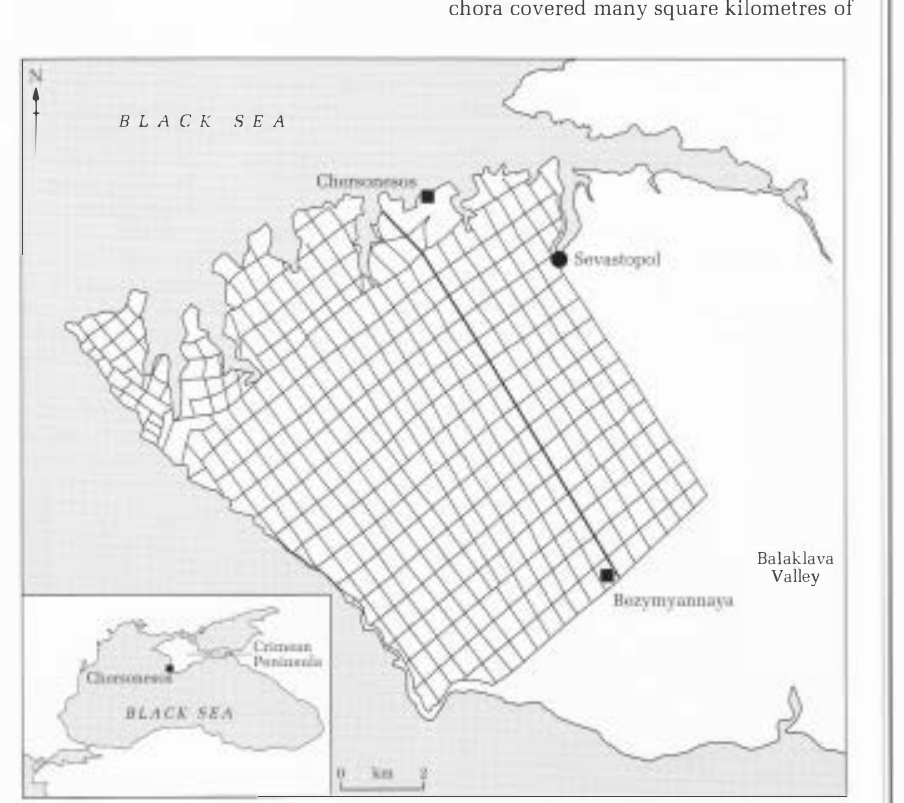
Figure 1 The location of ancient Chersonesus, showing the former extent of its chora (hinterland) divided into square homesteads occupying most of the Heraklean peninsula between Sevastopol and the Balaklava valley (based on Fig. 35 in the reference cited in n. 3